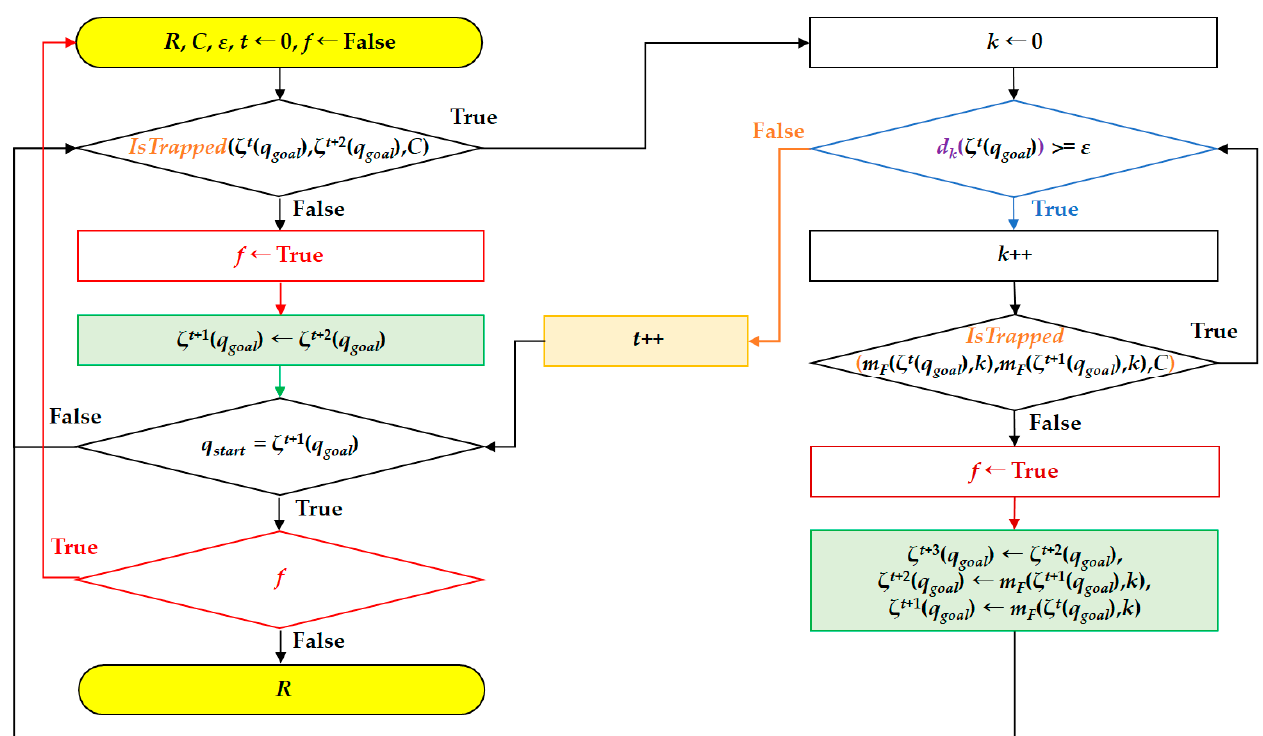
Figure 7. Flowchart of post triangular processing of midpoint interpolation method.